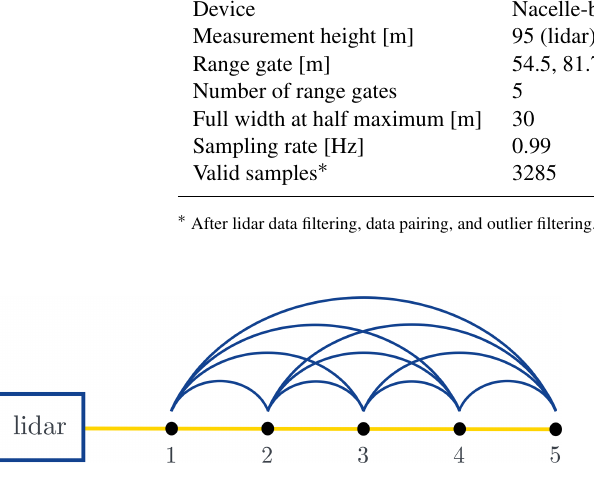
Figure 4. Pairing of different range gates for estimating coherence for Lidar Complex, given as an